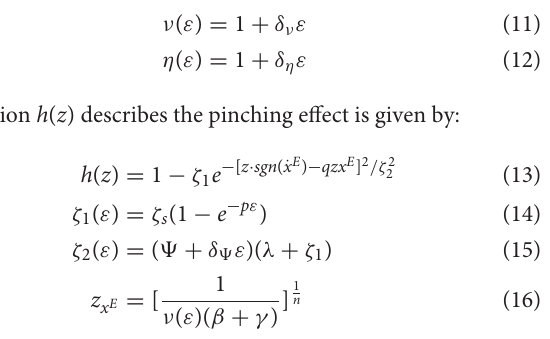
ν ( ε ) and η ( ε ) are degradation shape functions, and δ ν , δ η are degradation